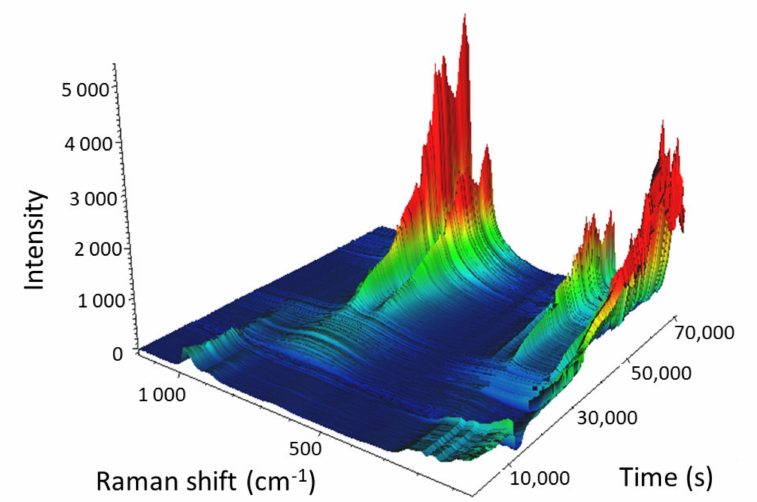
Figure 13. 3D view of the calcination of the W-supported mesoporous silica catalyst with a W content of 38 wt%. Heating: start temperature 25 ◦ C; temperature gradient 1 ◦ C / min; end temperature 500 ◦ C (in 28,738 s). Isotherm for 4 h (43,072 s). Cooling: start temperature 500 ◦ C; temperature ramp 1 ◦ C / min; end temperature 50 ◦ C (70,383 s).